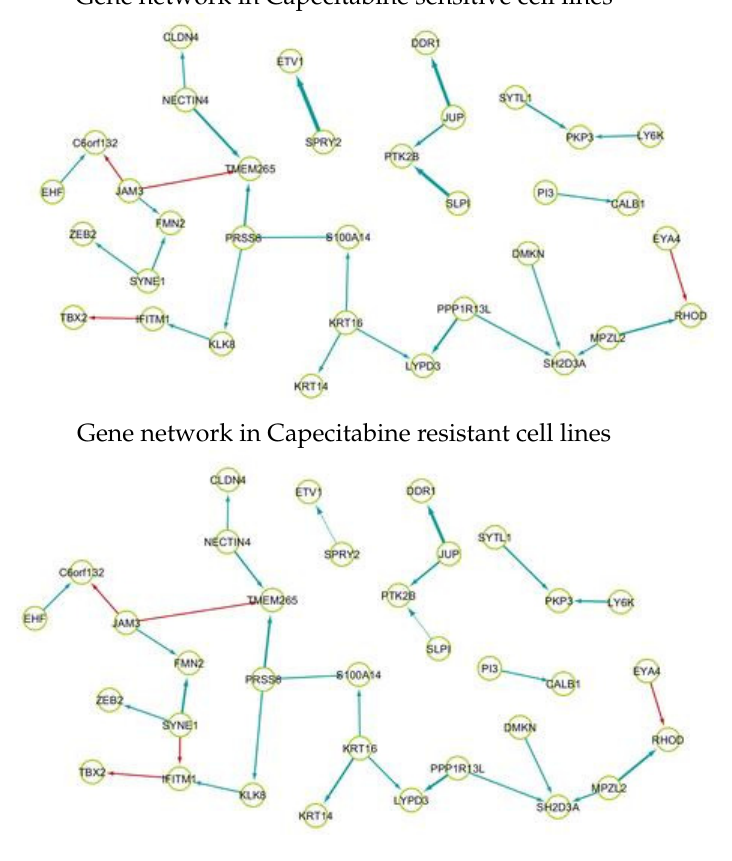
Figure 3. Gene regulatory networks of the crucial molecular interplays to oxaliplatin sensitivity prediction. Color of edge indicate negative (red) and positive (blue) effects of regular genes on their target